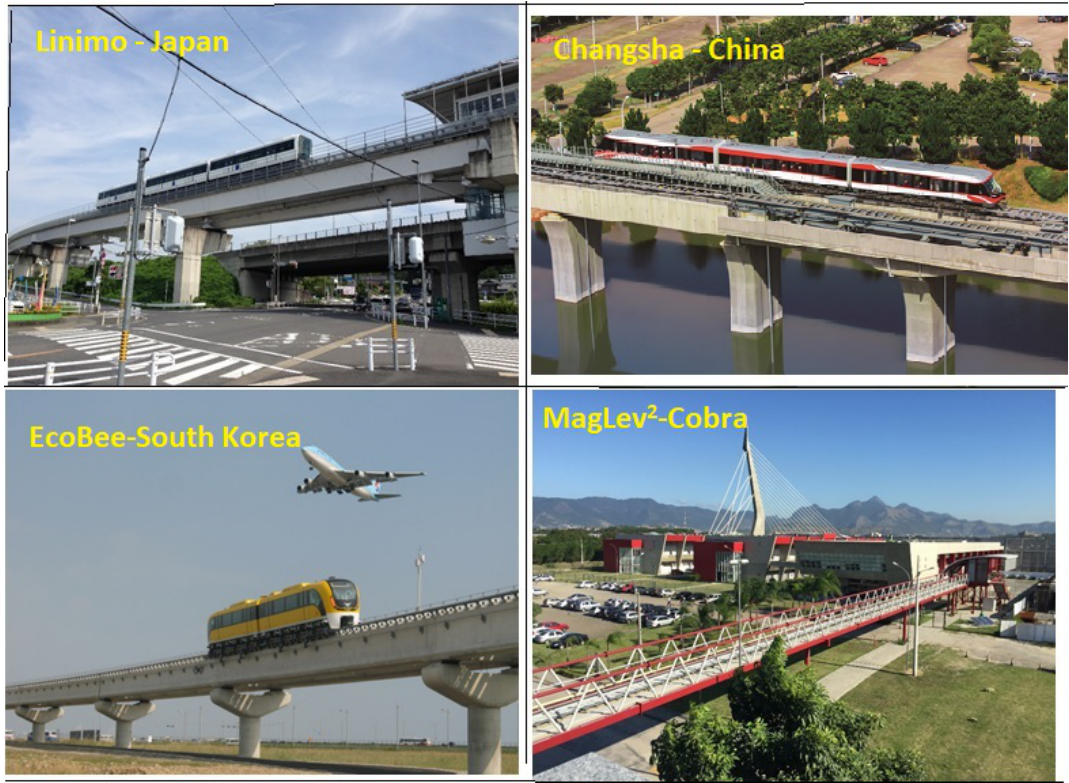
Figure 5. Comparison of MagLev Electromagnetic Levitation (EML) in urban commercial operation in Japan, China, South Korea with the MagLev 2 -Cobra experimental line, which uses SML levitation: lighter and slender.